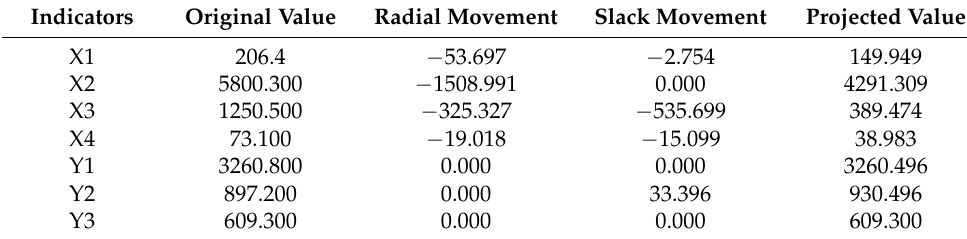
Table 7. The detailed results of the DMU6 slack